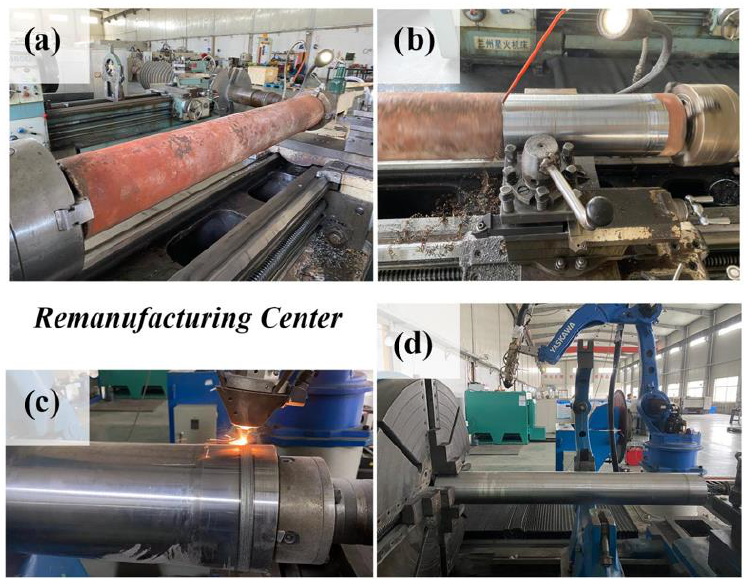
Figure 17. Remanufacturing of Cr5Mo hydrocracking furnace tube for a petrochemical enterprise: ( a ) serious oxidation of the Cr5Mo furnace tube; ( b ) surface processing of the furnace tube to removed oxide scale; ( c ) laser cladded IN718 on the surface of the Cr5Mo furnace tube; ( d ) surface processing and resizing after laser cladding.